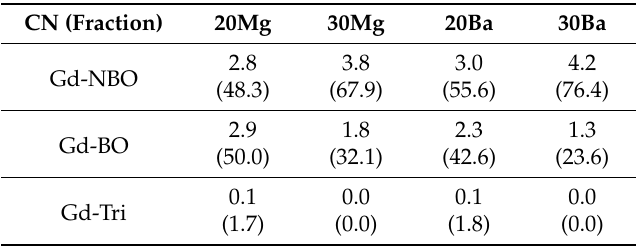
Table 6. Separation of Gd-O coordination numbers (CN) into nonbridging oxygen (NBO), bridging oxygen (BO), and tricluster oxygen ions (Tri). Fractions [%] are given in